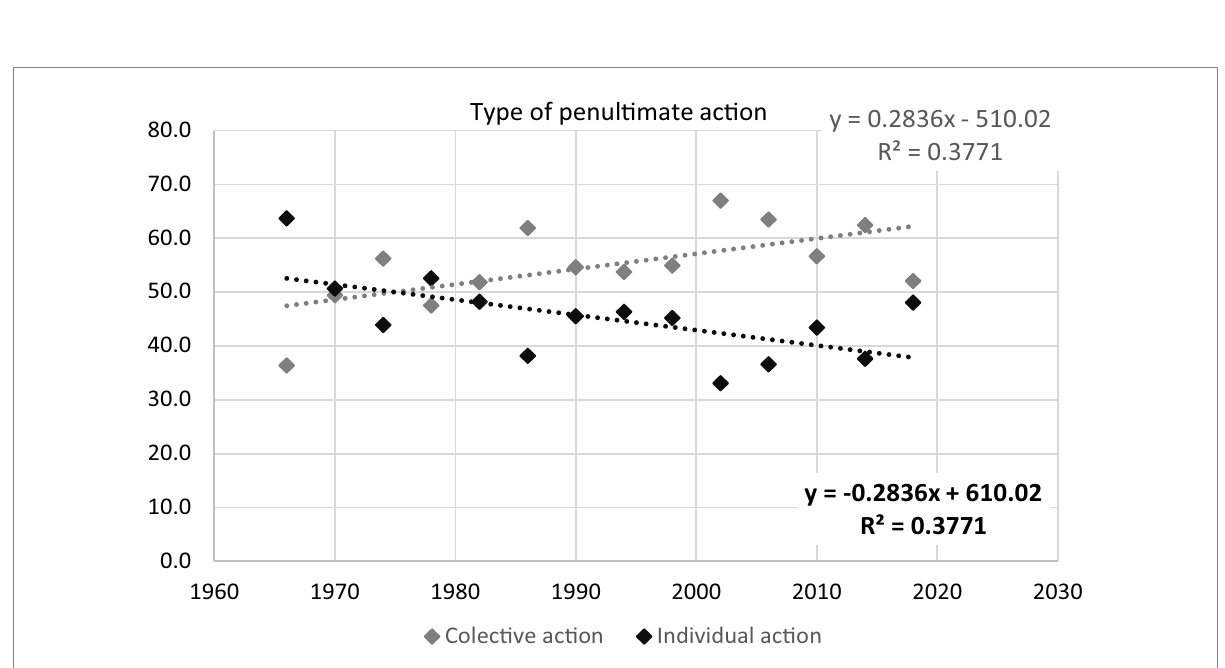
FIGURE 2 Regression analysis of the frequency of the type of penultimate action (collective and individual actions) through the 14 FIFA World